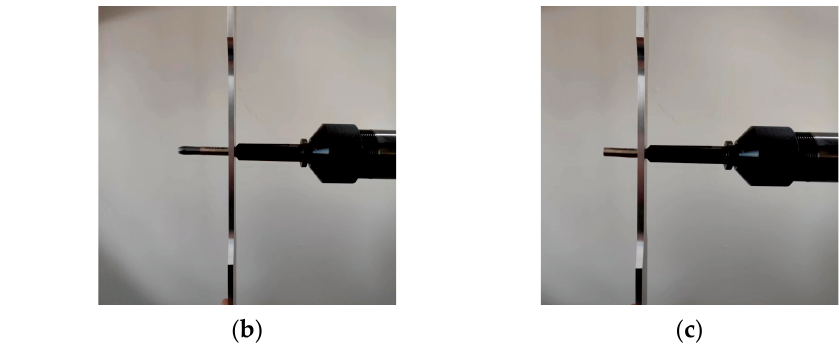
Figure 10. Explanation of the SSCE process: ( a ) the split sleeve and mandrel pass through the hole; ( b ) the pulling gun is started and the core rod is extruded through the hole with the split sleeve; ( c ) SSCE is completed.